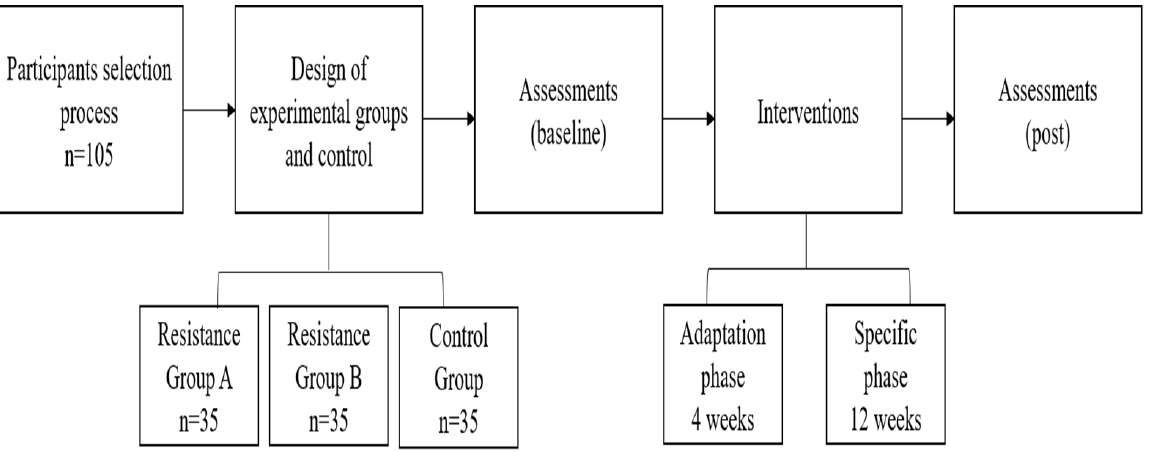
Figure 1. Flowchart of experimental design.